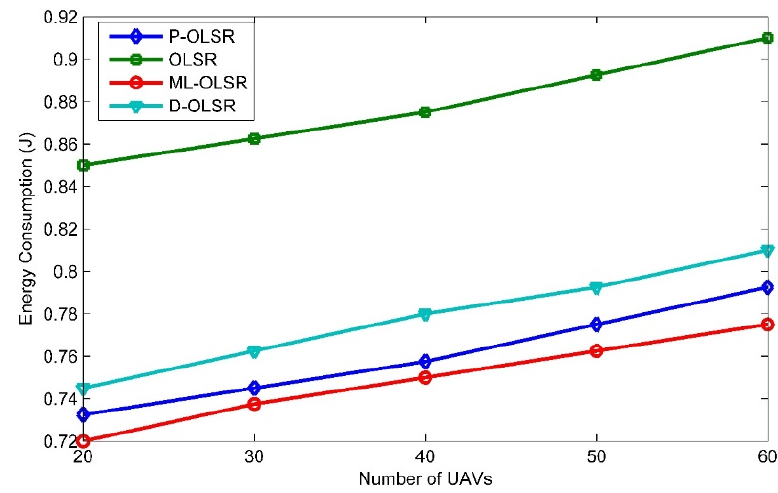
Figure 12. Energy consumption vs. number of UAVs.